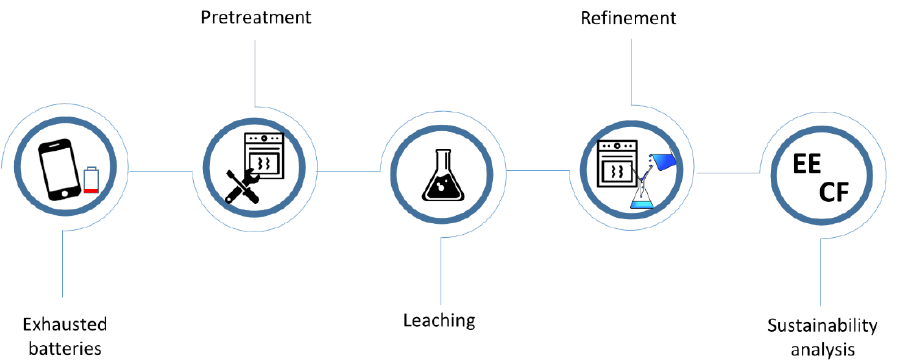
Figure 1. Schematic representation of the sustainability analysis in terms of Embodied energy (EE) and Carbon footprint (CF) of the metals extraction process.